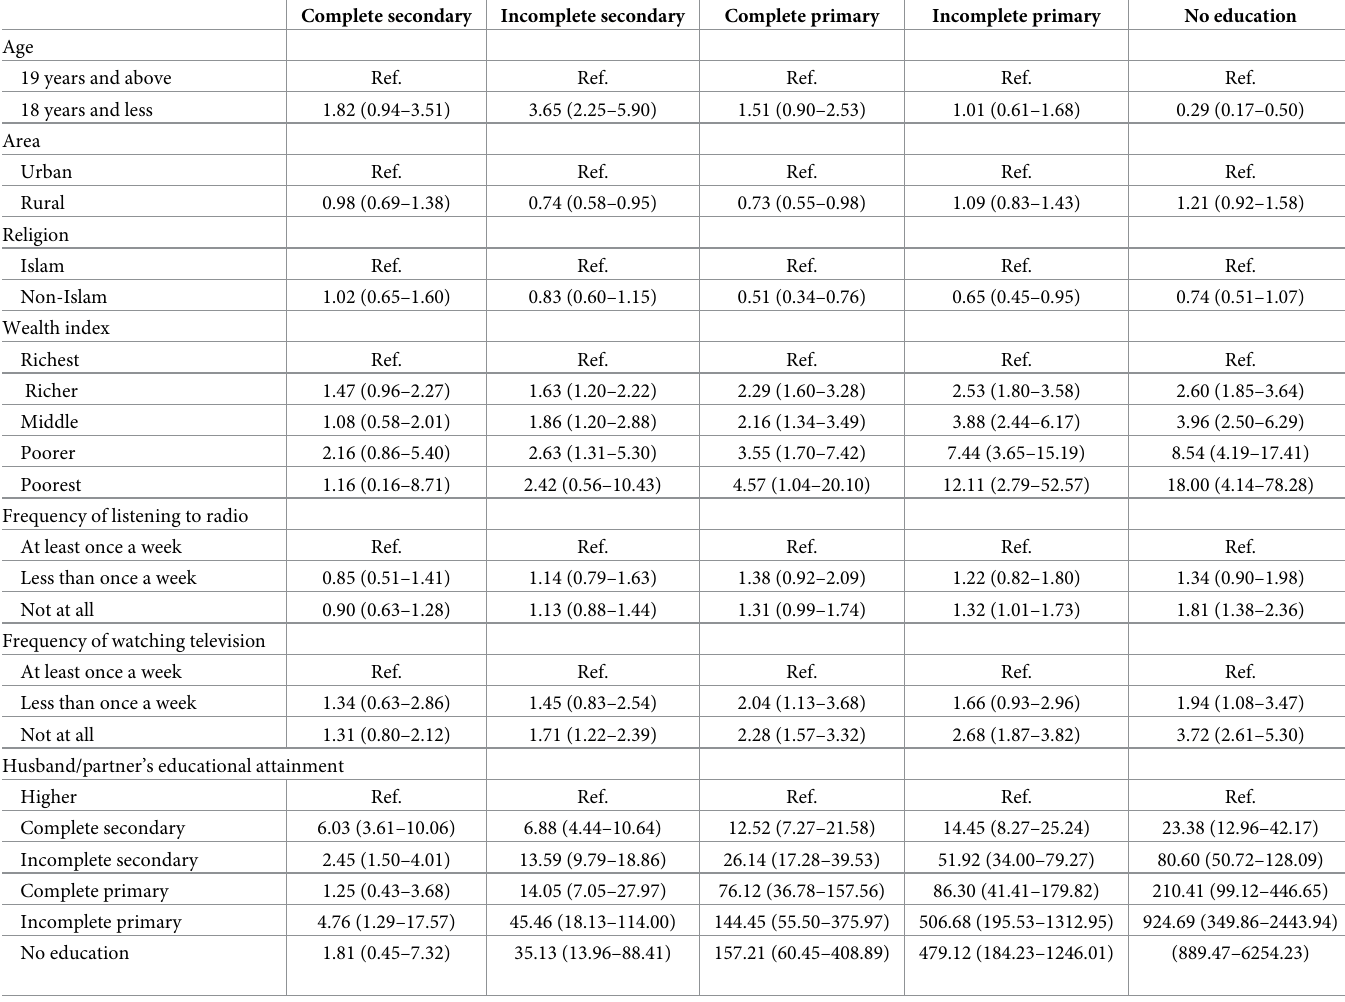
Table 2. Multivariable analysis 1 of maternal education level and different factors in